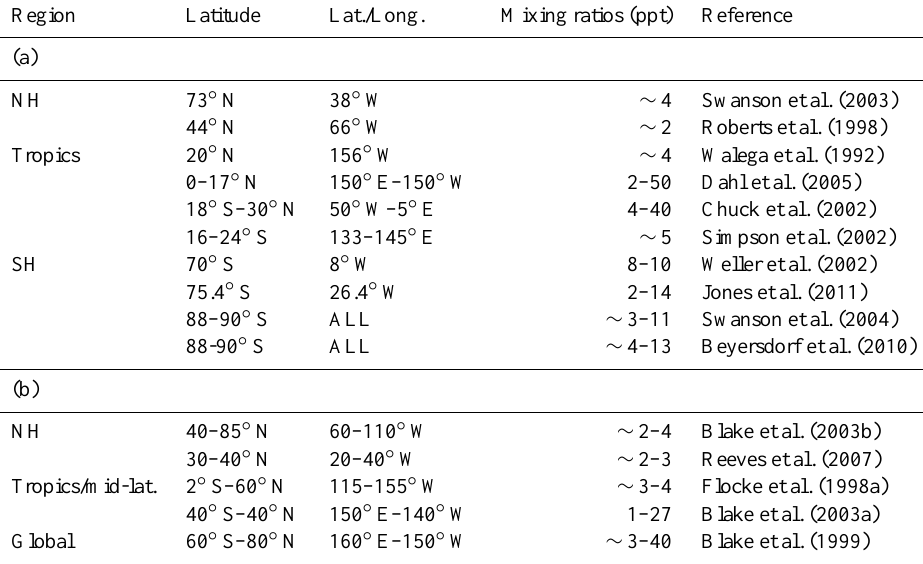
Table 1. (a) Mixing ratios of CH 3 ONO 2 measured at the surface over the last few decades. (b) The range of CH 3 ONO 2 mixing ratios measured in the FT (between 2 and 10km) during research flights over the last few decades from various measurement campaigns. Region Latitude Lat./Long. Mixing ratios